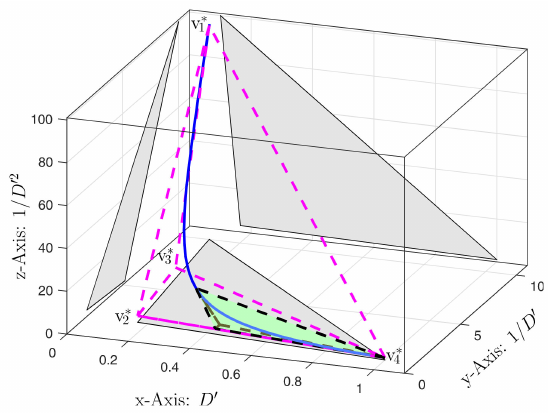
Figure 4. Plot of nonlinear uncertainty function (f(D’)) (solid line) and proposed polytope P 2020 for extended robustness (dashed pink line). The projections of the polytope are also shown in each respective plane. Note how P 2020 compares with P 2011 , which is shown here in black dashed lines and covers a much smaller parameter